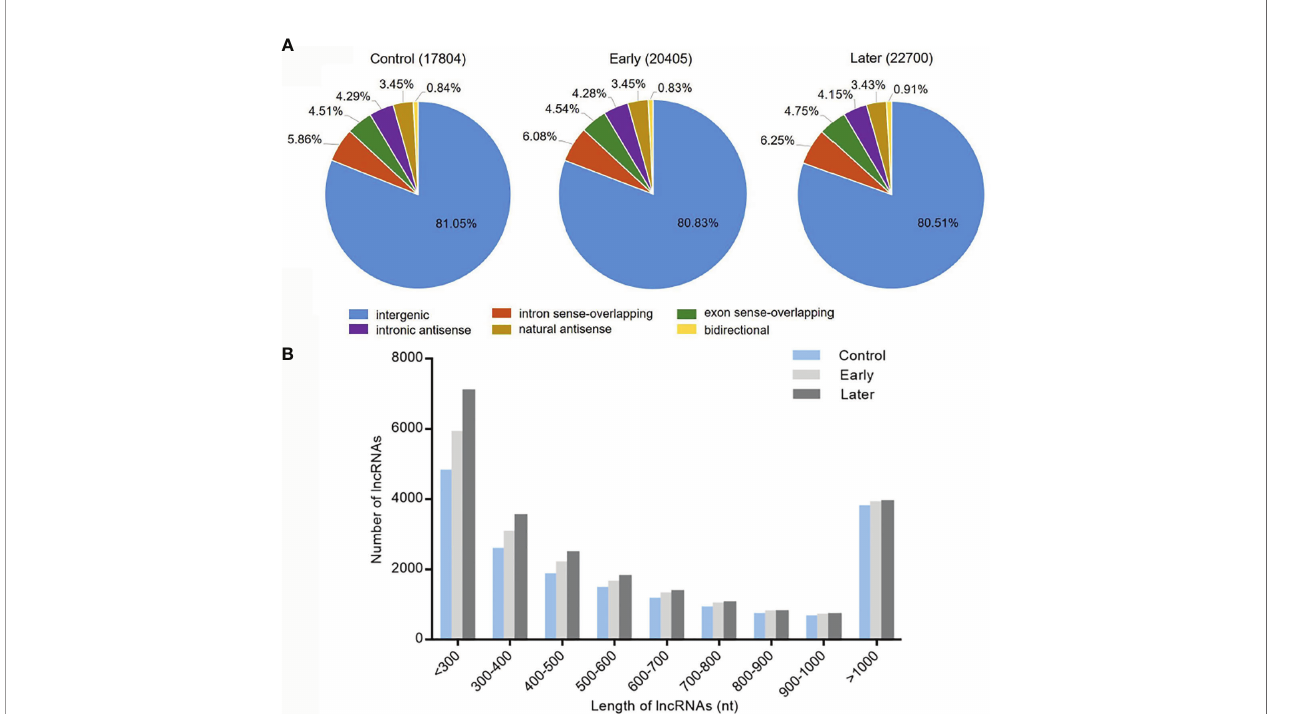
FIGURE 1 | Categories and features of the predicted sea cucumber lncRNAs. (A) Categories of sea cucumber lncRNAs divided according to sea cucumber genome annotation. The lncRNAs were classi fi ed into six types (intergenic, intron sense-overlapping, antisense, exon sense-overlapping, intronic antisense, bidirectional) in different groups (uninfected, at day 1 post-infection, at day 7 post-infection). (B) Length distribution of sea cucumber lncRNAs in response to Vibrio splendidus infection. The symbols indicated uninfected and at day 1 or day 7